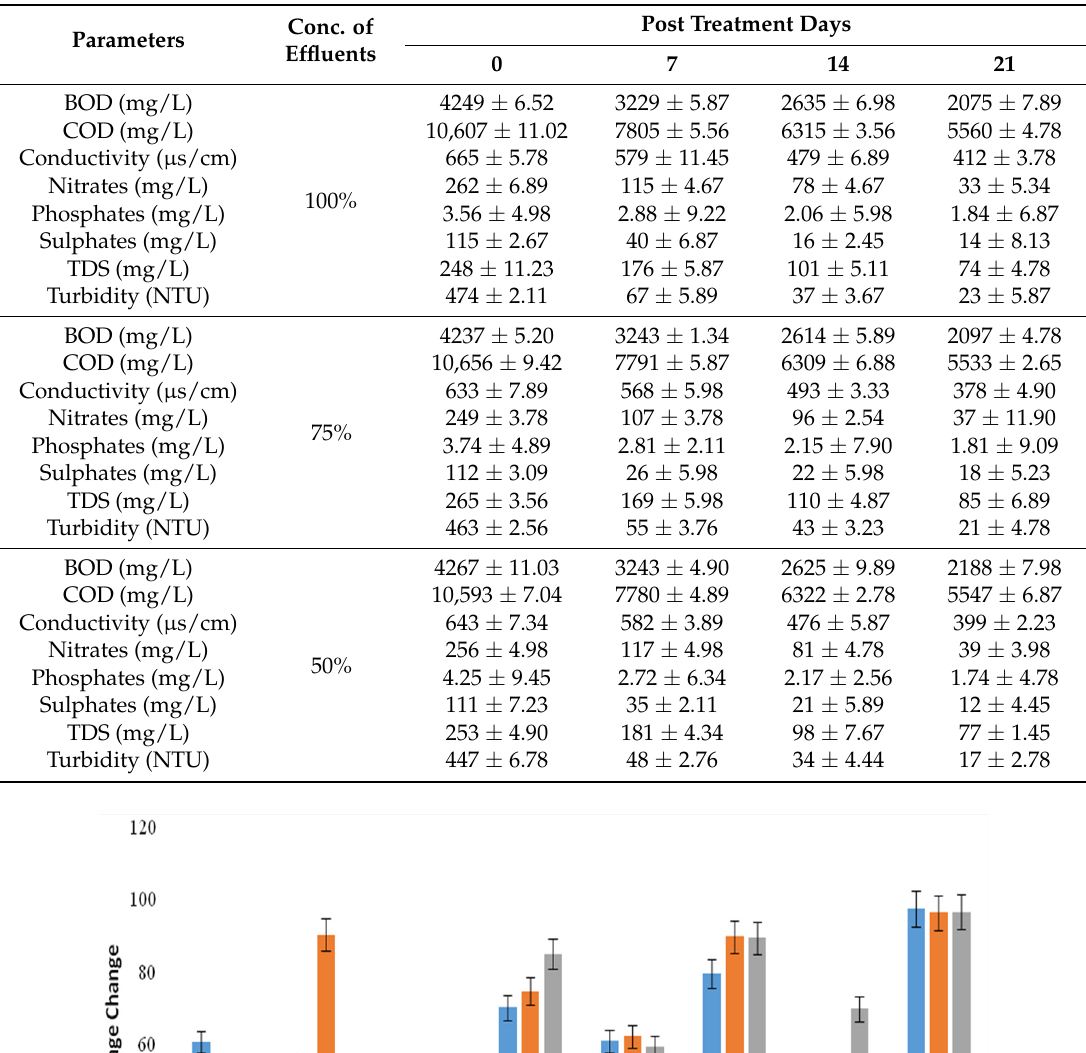
Table 3. The physicochemical features of different concentrations of tannery effluents treated with the syndicate.